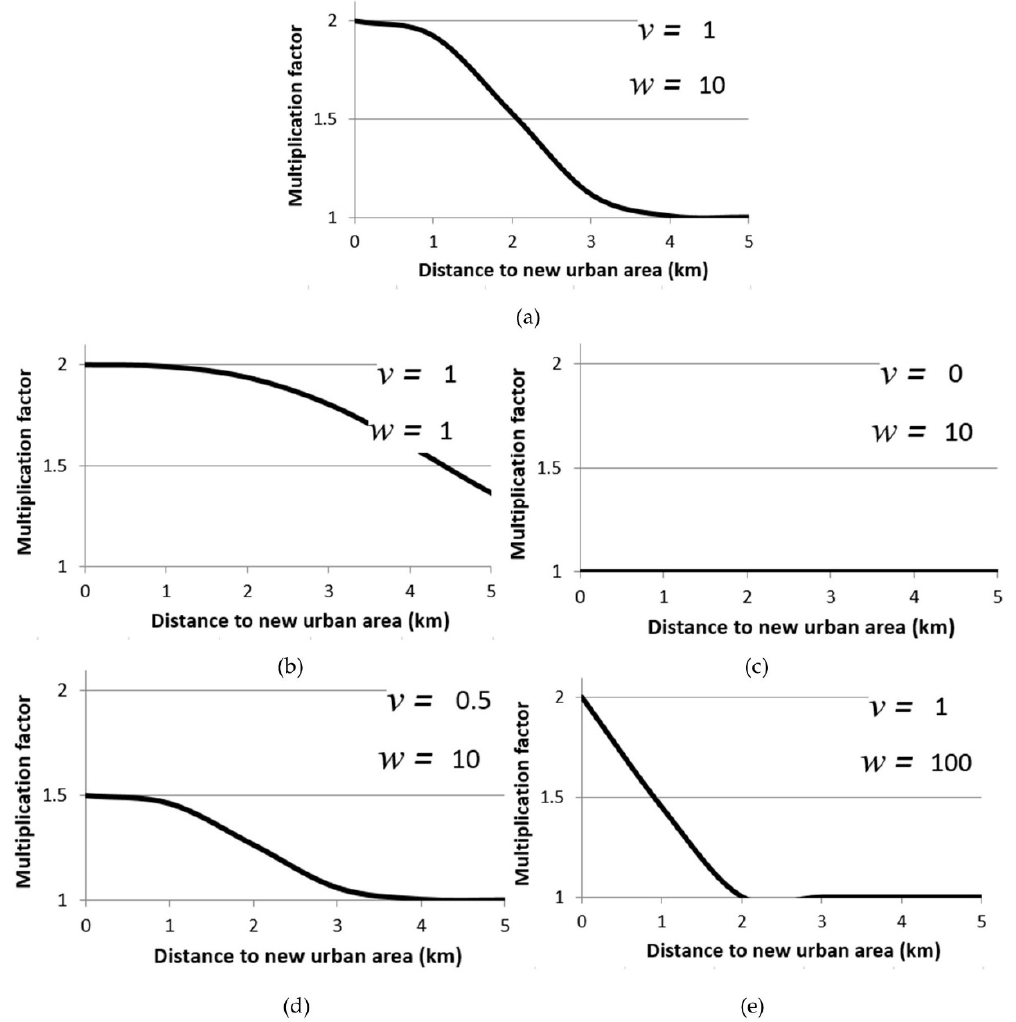
Figure 3. The rate of land value change as a distance decay function from a new urban area.